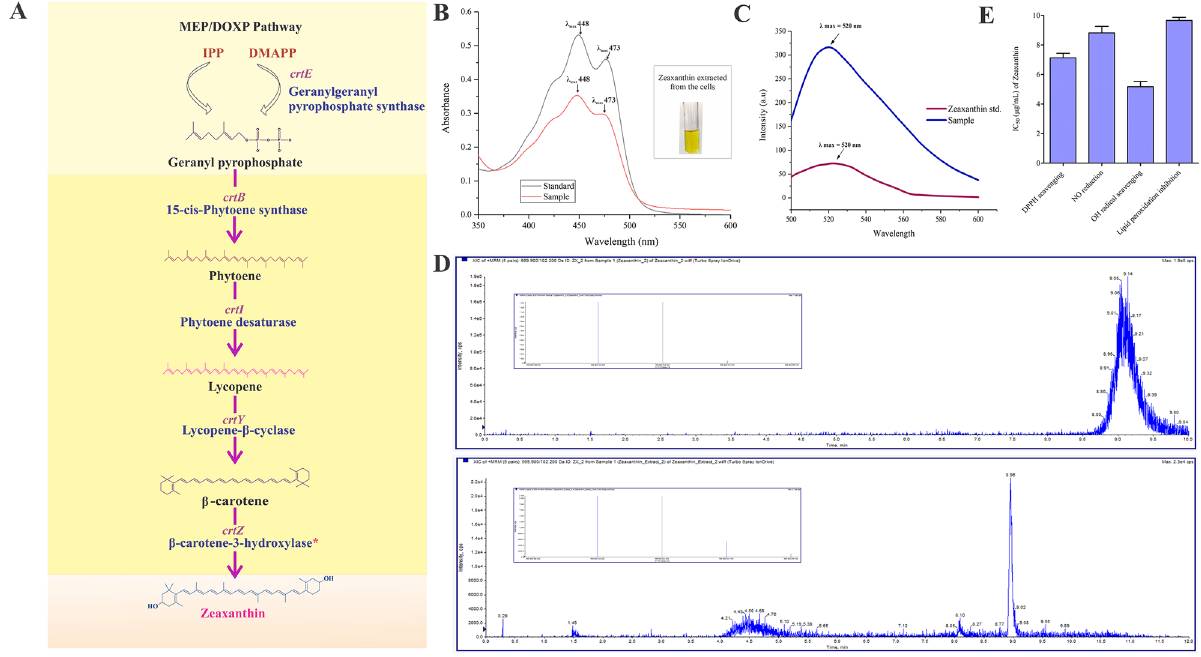
Figure 3. Zeaxanthin biosynthesis in H. malpeensis YU-PRIM-29 T . ( A ) Complete zeaxanthin biosynthesis pathway as predicted from genomic sequence data. The biosynthesis pathway was constructed based on the KEGG database, PATRIC genome annotation and Prokka. *Result obtained from tBLASTn analysis and details are provided in the Supplementary Tables S5 and S10. ( B ) UV–Vis spectra of zeaxanthin extracted from H. malpeensis. Standard zeaxanthin was used for comparison. Inset showing solvent extracted zeaxanthin from the cells. ( C ) Fluorescence spectra of zeaxanthin extracted from H. malpeensis compared to standard zeaxanthin showing maximum absorption at 520 nm. ( D ) Targeted LC–MS MRM spectra of extracted zeaxanthin with the standard acquired in positive polarity. Two transitions were observed in the extract. ( E ) IC 50 values (µg mL −1 ) for zeaxanthin showing DPPH scavenging, NO reduction, OH radical scavenging and lipid peroxidation inhibition activities. The bars represent mean ± SD of triplicate Pigment biosynthesis. Microbial pigments occur in two forms; either secreted by the cell or cell bound. In this bacterium the intense yellow pigment is cell bound and was water insoluble. Hence, it required extraction using organic solvents. The genes crtB, crtI, crtY and crtZ responsible for the carotenoid biosynthesis were pre- sent. These genes are responsible for the enzymes of 15-cis-phytoene synthase (EC 2.5.1.32) that converts gera- nyl pyrophosphate to phytoene, phytoene desaturase (EC 1.3.99.31), converts phytoene to lycopene, lycopene β-cyclase (EC 5.5.1.19) converts lycopene to β-carotene and β-carotene-3-hydroxylase (EC 1.14.15.24) converts β-carotene to zeaxanthin. The detailed biosynthesis pathway identified for the zeaxanthin production is given in Fig. 3A. Further, the yellow pigment produced by the bacterium was extracted from the cell pellets. It was insoluble in water and was extractable in organic solvent methanol. The visible spectra of the extracted yellow pigment showed characteristic absorption peaks with λ max 448 nm and a shoulder peak at 429 nm corresponding to that of zeaxanthin used as a standard 31,32 (Fig. 3B). The fluorescence spectral characteristics also corresponded to the zeaxanthin pigment (Fig. 3C). The LC–MS/MS data obtained against the standard confirms the presence of zeaxanthin (Fig. 3D). The isolated pigment showed potent antioxidant activities with IC 50 values of 7.13 µg, 8.82 µg, 5.17 µg and 9.66 µg for DPPH scavenging, nitric oxide reduction, hydroxyl radical scavenging and lipid peroxidation inhibition respectively (Fig. 3E). KEGG annotation further revealed the enzymes involved in other pigment production pathways namely beta- lain pathway and riboflavin pathway. The betalain biosynthesis pathway begins with L-tyrosine that is converted to L-DOPA, which in the presence of 4,5-DOPA dioxygenase extradiol (EC 1.13.11.-) is converted to betalamic acid. This conjugates with amino acids spontaneously and forms yellow betaxanthins. The 4,5-DOPA dioxygenase extradiol gene is involved in this pathway. Riboflavin is a yellow coloured water-soluble pigment that is produced by a wide variety of microorganisms and its biosynthesis in H. malpeensis was identified using KEGG. The impor- tant proteins in the pathway such as RibA (EC 3.5.4.25), RibD1 (EC 3.5.4.26), RibD2 (EC 1.1.1.193), YigB (EC 3.1.3.104), RibH (EC 2.5.1.78), RibE (EC 2.5.1.9), RibF (EC 2.7.1.26), FAD1 (EC 2.7.7.2), RibB (EC 4.1.99.12) and SsuE (EC 1.5.1.38) were annotated using the genome data. The pathway begins with purine metabolism with seven enzymes namely; GTP cyclohydrolase II (RibA), pyrimidine deaminase (RibD1), pyrimidine reductase (RibD2), uracil phosphatase (YigB), 3,4-DHBP synthase (RibH) and ribityllumazine synthase (RibE) for the formation of the pigment (Supplementary Table S5). Apart from these enzymes, flavin mononucleotide (FMN) hydrolase (EC 3.1.3.102) that converts FMN to riboflavin is present.